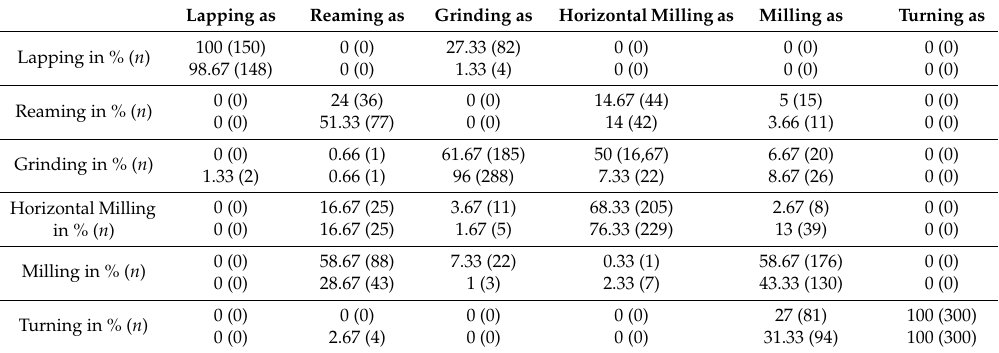
Table 2. Classification performance of the CNN trained with the full training set A1–E6 with actual measurement data after 2000 training steps (upper row) and 20,000 steps (lower